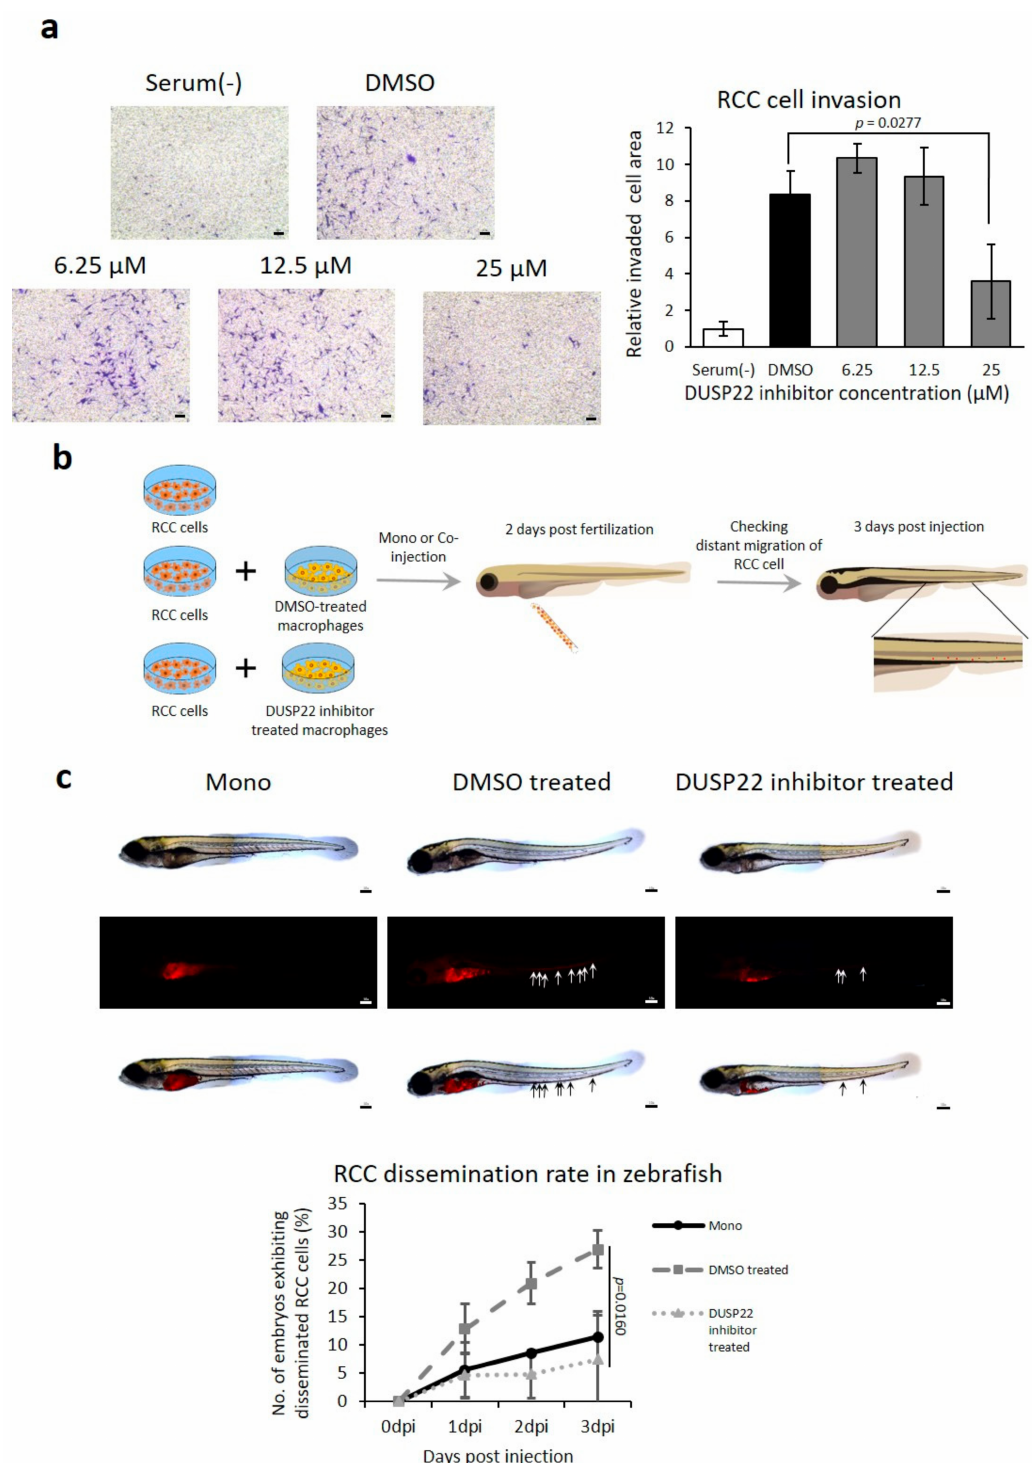
Figure 5. Reduced cancer cell invasion and metastasis in vivo by inhibition of DUSP22 . ( a ) Inhibitory effect of DUSP22 targeting drug BML-260 on the invasion assay of RECNA RCC cells cocultured with RAW264.7 macrophages. Scale bar = 100 µ m. ( b ) Schematic of the protocol to investigate the effect of macrophage DUSP22 inhibition on dissemination (early stage of metastasis) in cotransplanted RCC in vivo. ( c ) Representative microscopic images of fish larvae post- transplantation and the RCC dissemination rate with RCC alone ( n = 39) or cotransplanted with DMSO-treated macrophages ( n = 39) or BML-260-treated macrophages ( n = 44). Disseminated RCC cells were visualized by labelling with DiI. Arrows indicate tumor foci disseminated from the injection site (yolk sac). Scale bar = 100 µ